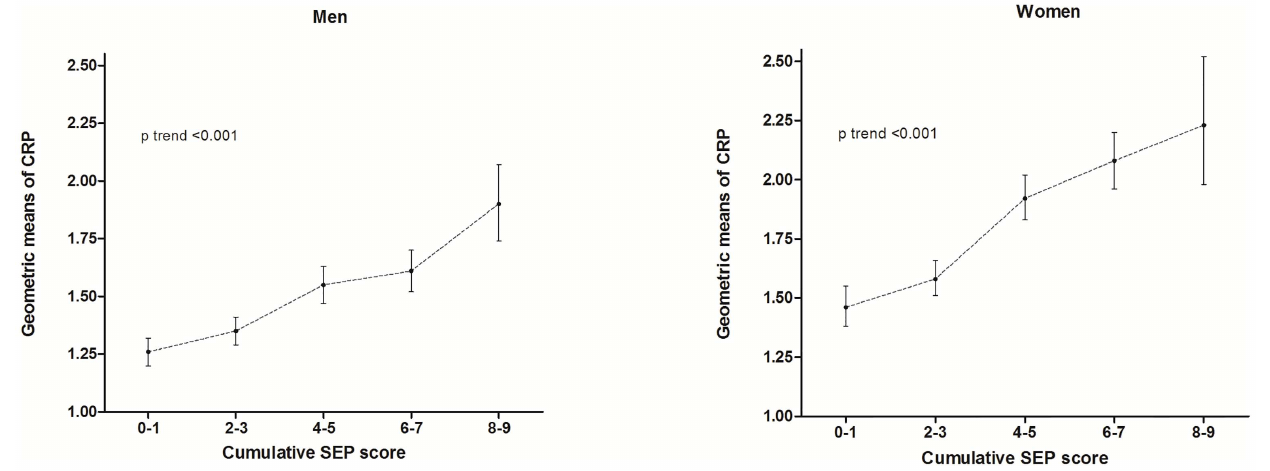
Figure 2. Age adjusted geometric means (95% confidence interval) of C-reactive protein among men and women by the cumulative SEP score that ranged between zero to nine, with higher values reflecting worse life course SEP. Brazilian Longitudinal Study of Adult Health (ELSA-Brasil), 2008–2010. doi:10.1371/journal.pone.0108426.g002 PLOS ONE |